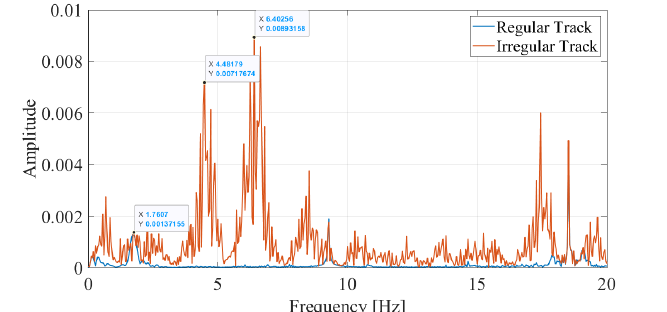
Figure 16. Fourier Amplitude Spectrum of vibrations recorded on the bogie for track profile B for V = 20